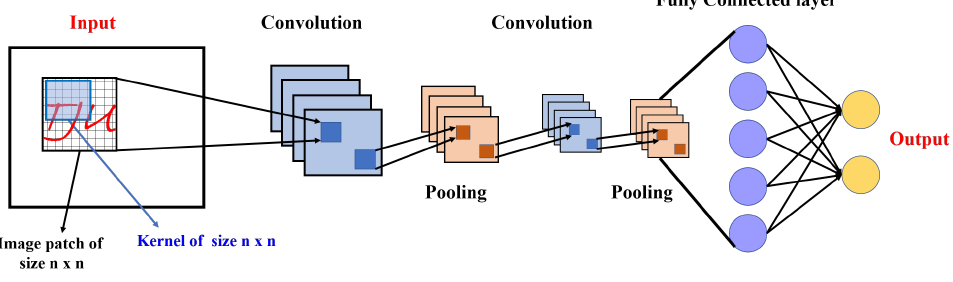
Figure 5. Example of CNN